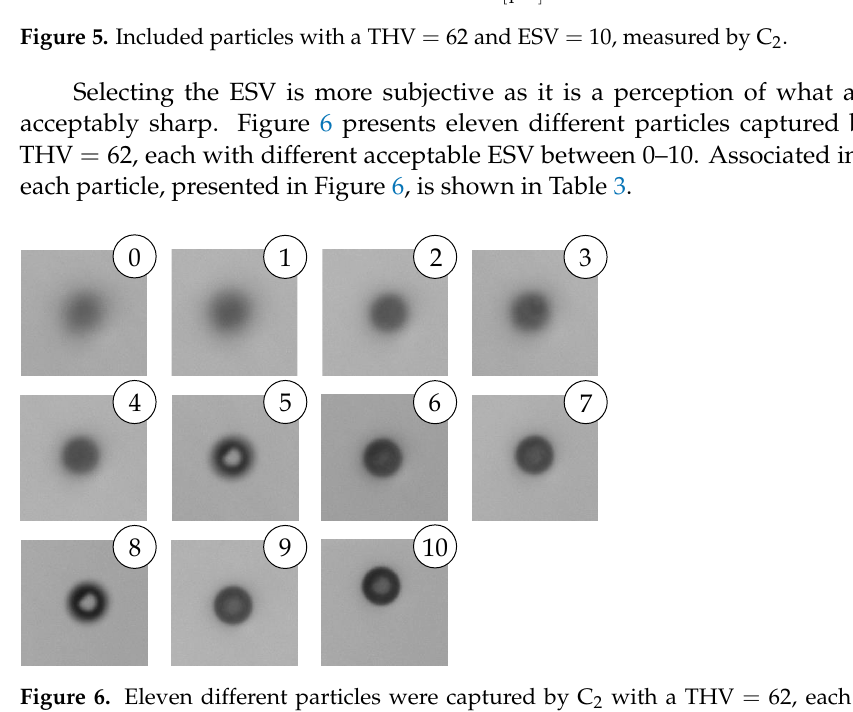
Figure 5. Included particles with a THV = 62 and ESV = 10, measured by C 2 .